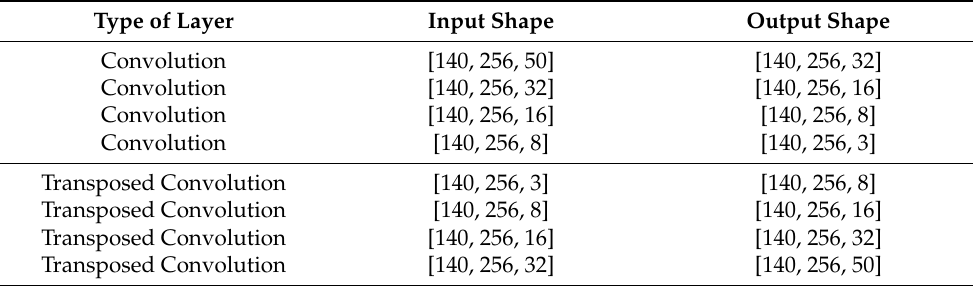
Table A2. Autoencoder architecture. All layers kernel are of size [3, 3] with stride and padding set to 1, to ensure the same height and width as the input image. Rectified linear unit (ReLU) activation is used after each layer except the fourth and eighth layers. The upper half of the table describes the encoder architecture while the lower half represents the